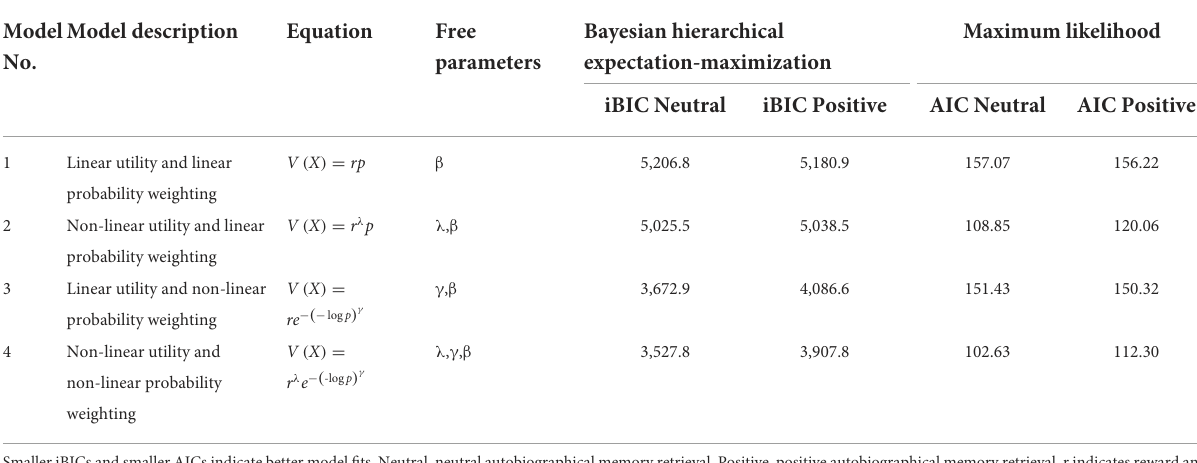
TABLE 1 Model specification and fitting